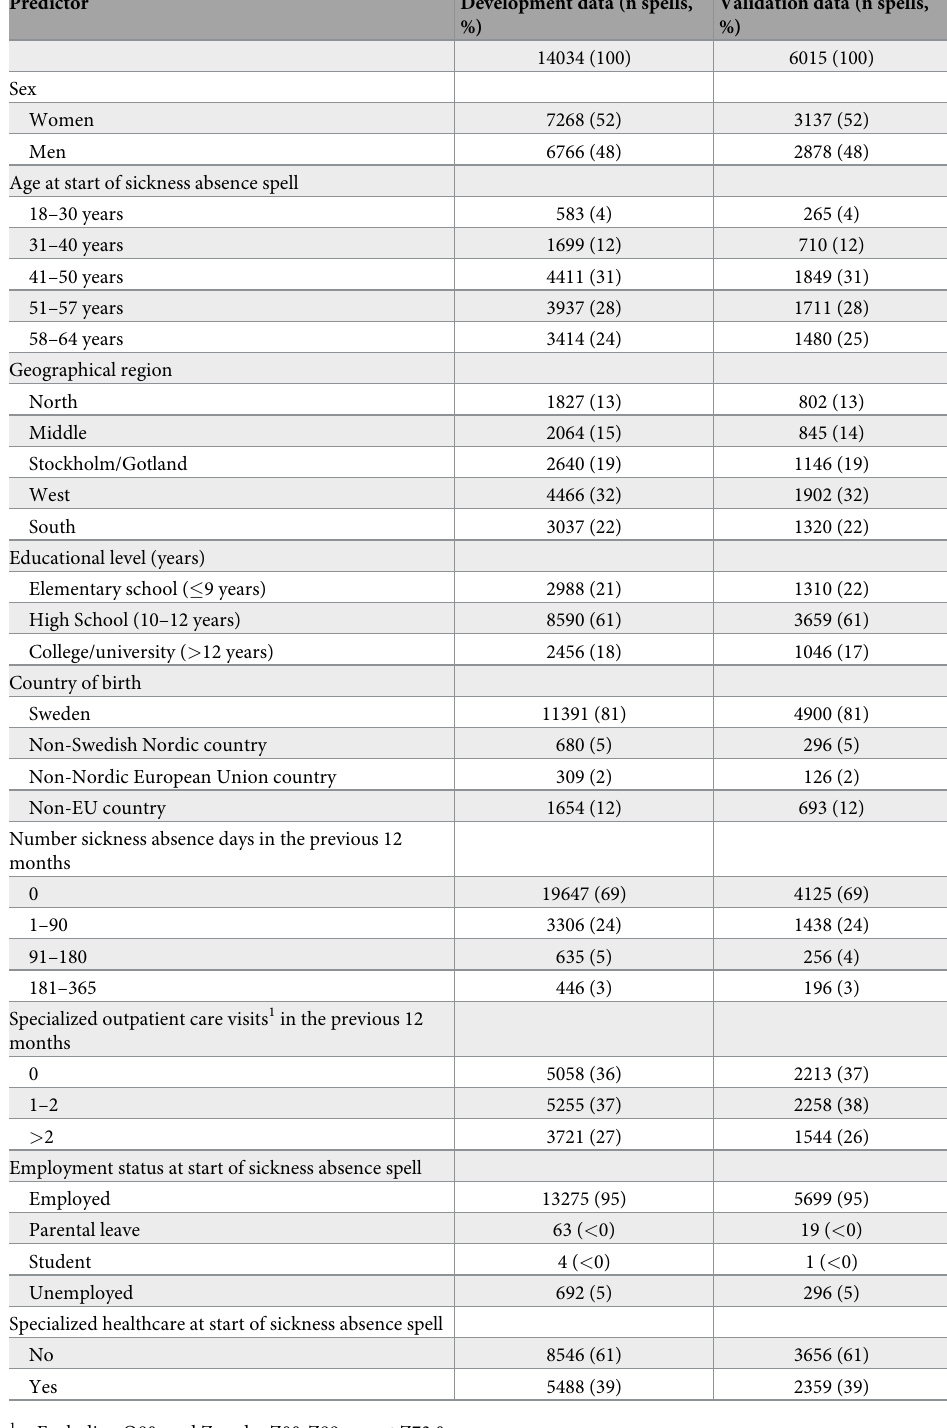
Table 2. Tabulation of baseline predictors for the development and validation data